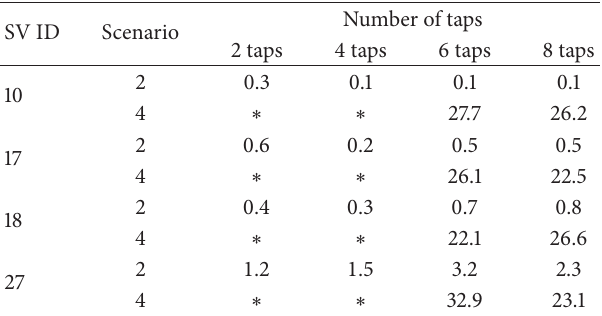
Table 9: Measurement errors using distortion metric: for one CW and six CW (in meters).